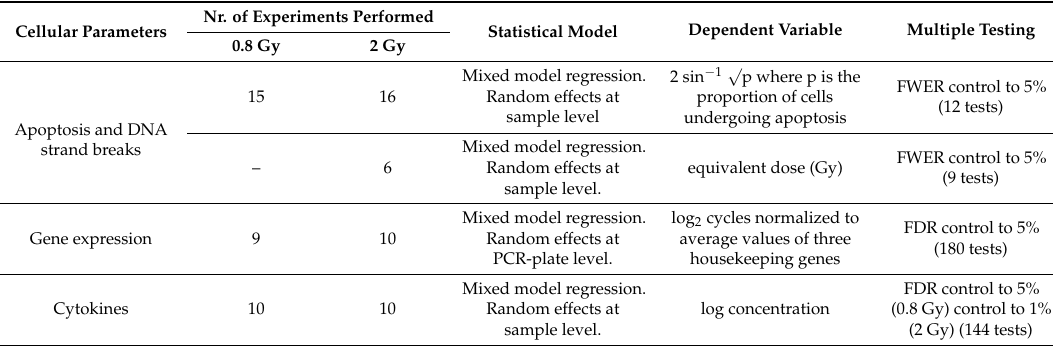
Table 6. List of statistical methods applied for each measured